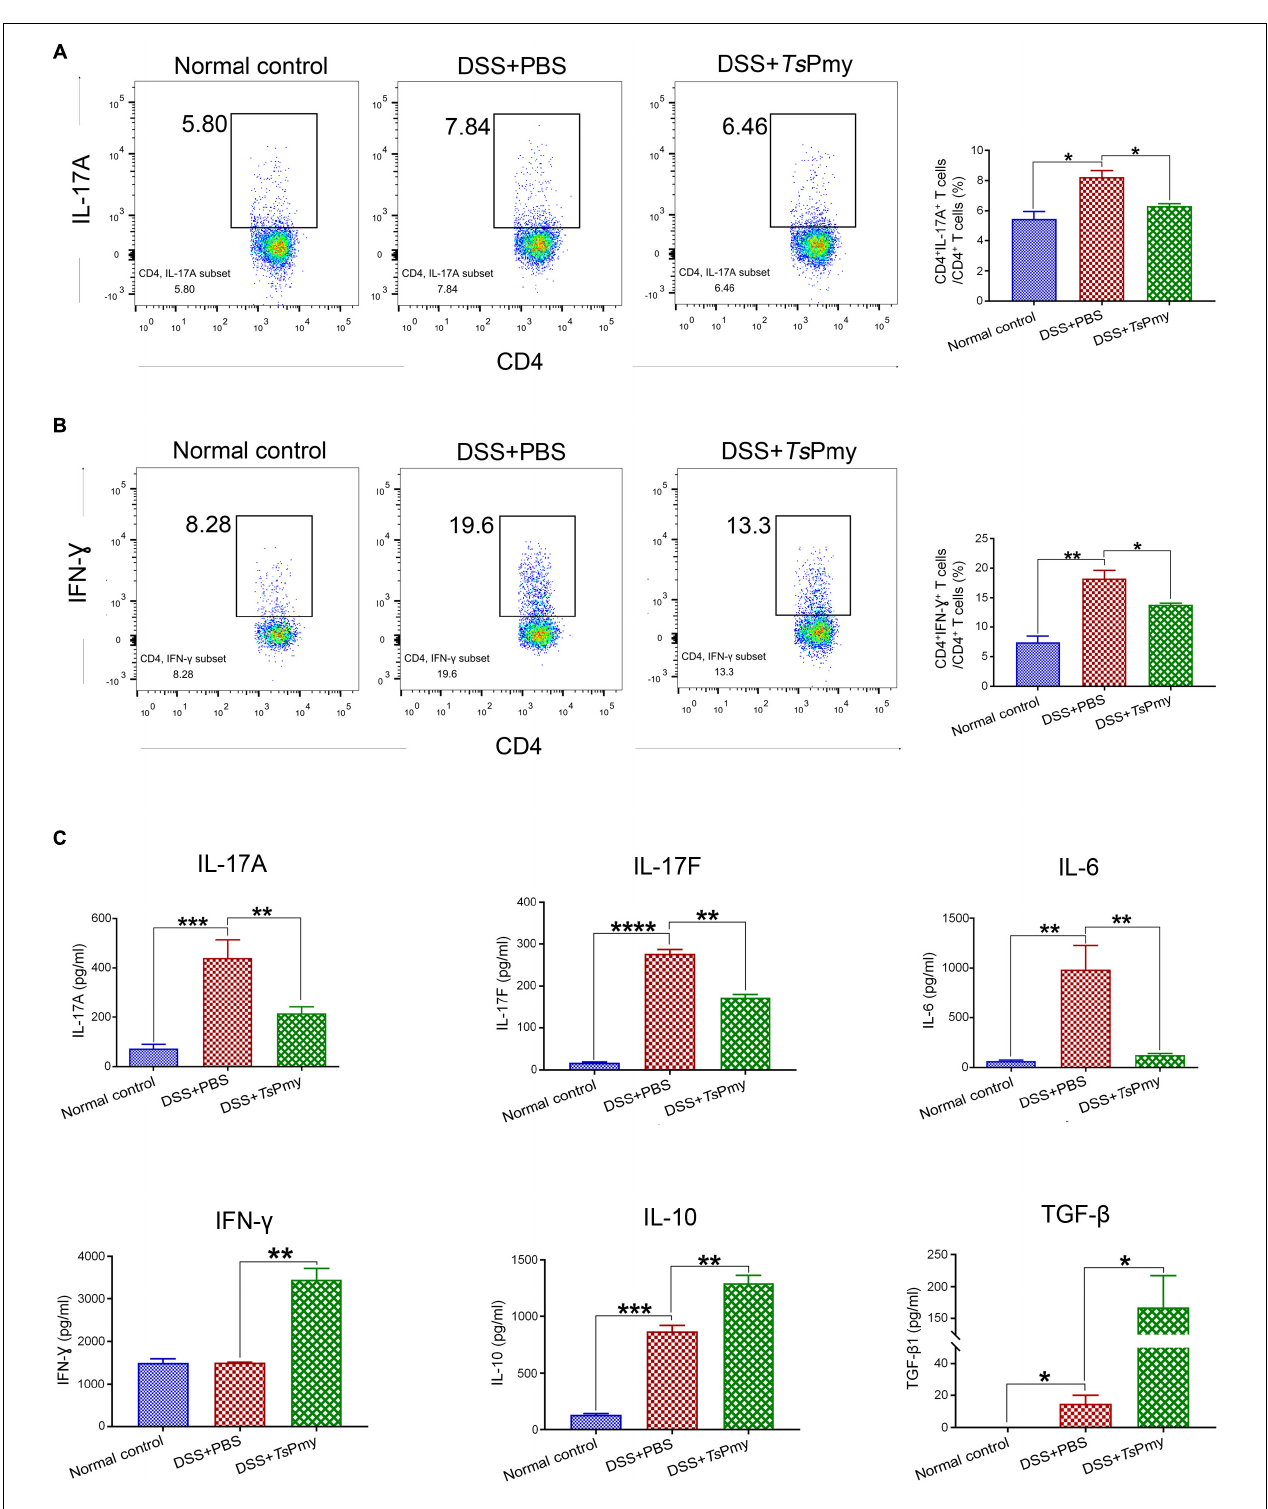
FIGURE 4 | Treatment with r Ts Pmy reduces pro-inflammatory responses and enhances regulatory cytokines in cLP of mice with DSS-induced colitis. Lamina propria mononuclear cells (LPMCs) were isolated from distal colons of mice treated with r Ts Pmy or PBS on day 8. Flow cytometry shows CD3 + CD4 + expressed with IL-17A (A) or IFN- γ (B) . The gating strategy is shown in Supplementary Figure 1 . The statistical analyses of the percentage of cells are shown on the right ( n = 5). (C) After being stimulated with anti-CD3/CD28 mAbs for 48 h, LPMCs secretions of IL-17A, IL-17F, IL-6, IFN- γ , IL-10, and TGF- β were measured in the culture supernatants by Luminex or ELISA. The data represent the mean ± SEM ( n = 3–5). * p < 0.05, ** p < 0.01, *** p < 0.001, **** p < 0.0001. cLP, colonic lamina propria.